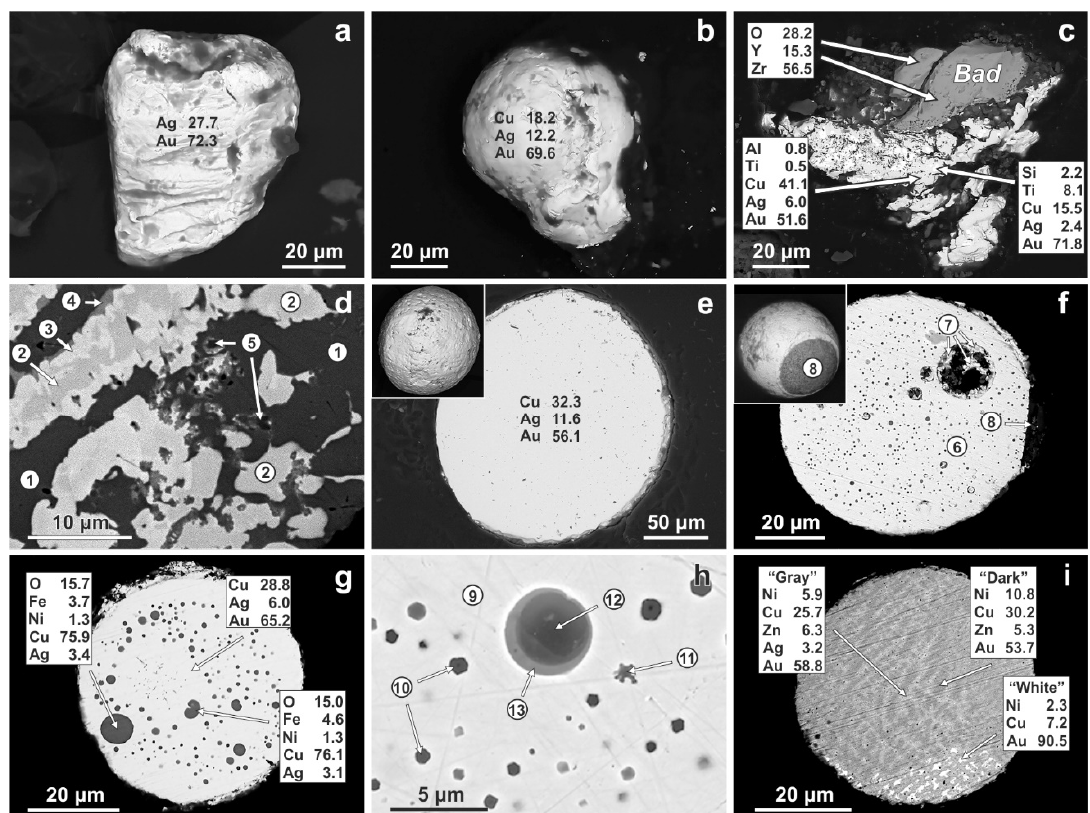
Figure 13. Gold-bearing alloys in explosive breccias ( a , c – e ) and iron-oxide ores ( b , f – i ) from the Kostenga deposit: ( a )— irregular Ag-Au grain with elements of the surface sculpture; ( b )—Cu-Ag-Au alloy with distorted spherical shape; ( c )— highly irregular grain associated with baddeleyite; ( d )—enlarged fragment of the internal structure of the grain shown in ( c ) with exsolved Ti-Cu-Ag-Au phases (points 1–5 correspond to EDS analyses in Table 2); ( e )—internal structure of a homogeneous Cu-Ag-Au spherule; ( f )—exterior view (inset) and internal structure of Cu-Ag-Au spherule with partial rim and spherical inclusions of Cu-rich composition, as well as spherical cavities encrusted with Cu-Ag-Au dendrites; ( g )— cross-section of Cu-Ag-Au spherule with large spherical Cu-rich inclusions; ( h )—cross-section of Cu-Ag-Au spherule with faceted and dendrite-like Cu-rich inclusions and a single, relatively large composite Cu-rich phase with meniscus-like texture; ( i )—internal structure of Ni-Cu-Zn-Ag-Au spherule with exsolution textures. Numbers (data points) in figures a– i correspond to EDS analyses in Table 2.